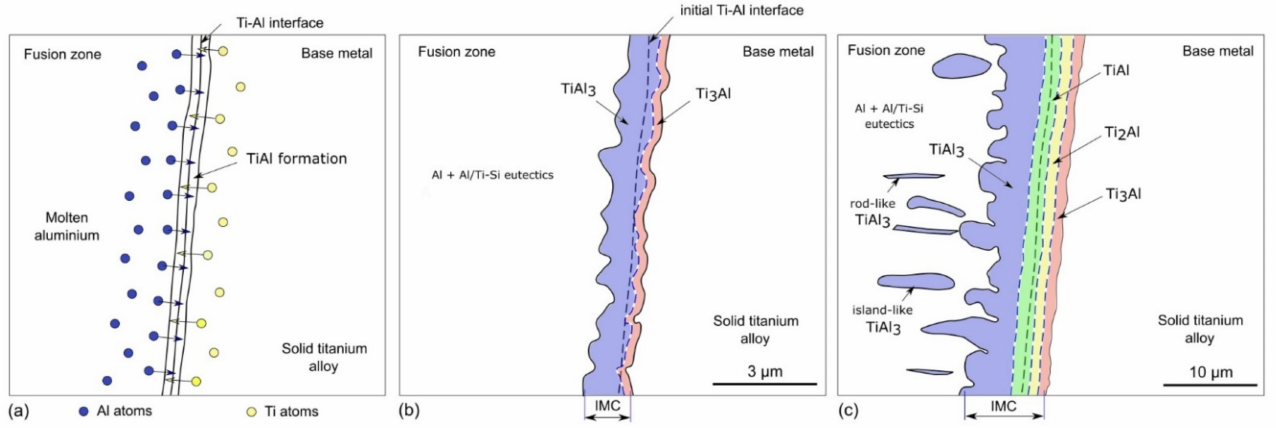
Figure 25. Formation and growth of Ti–Al IMC layer during welding according to progress in weld thermal cycle: ( a ) initial formation of Ti–Al phases; ( b ) Ti–Al phases during low heat input parameters; and ( c ) Ti–Al phases during high heat input parameters. Based on